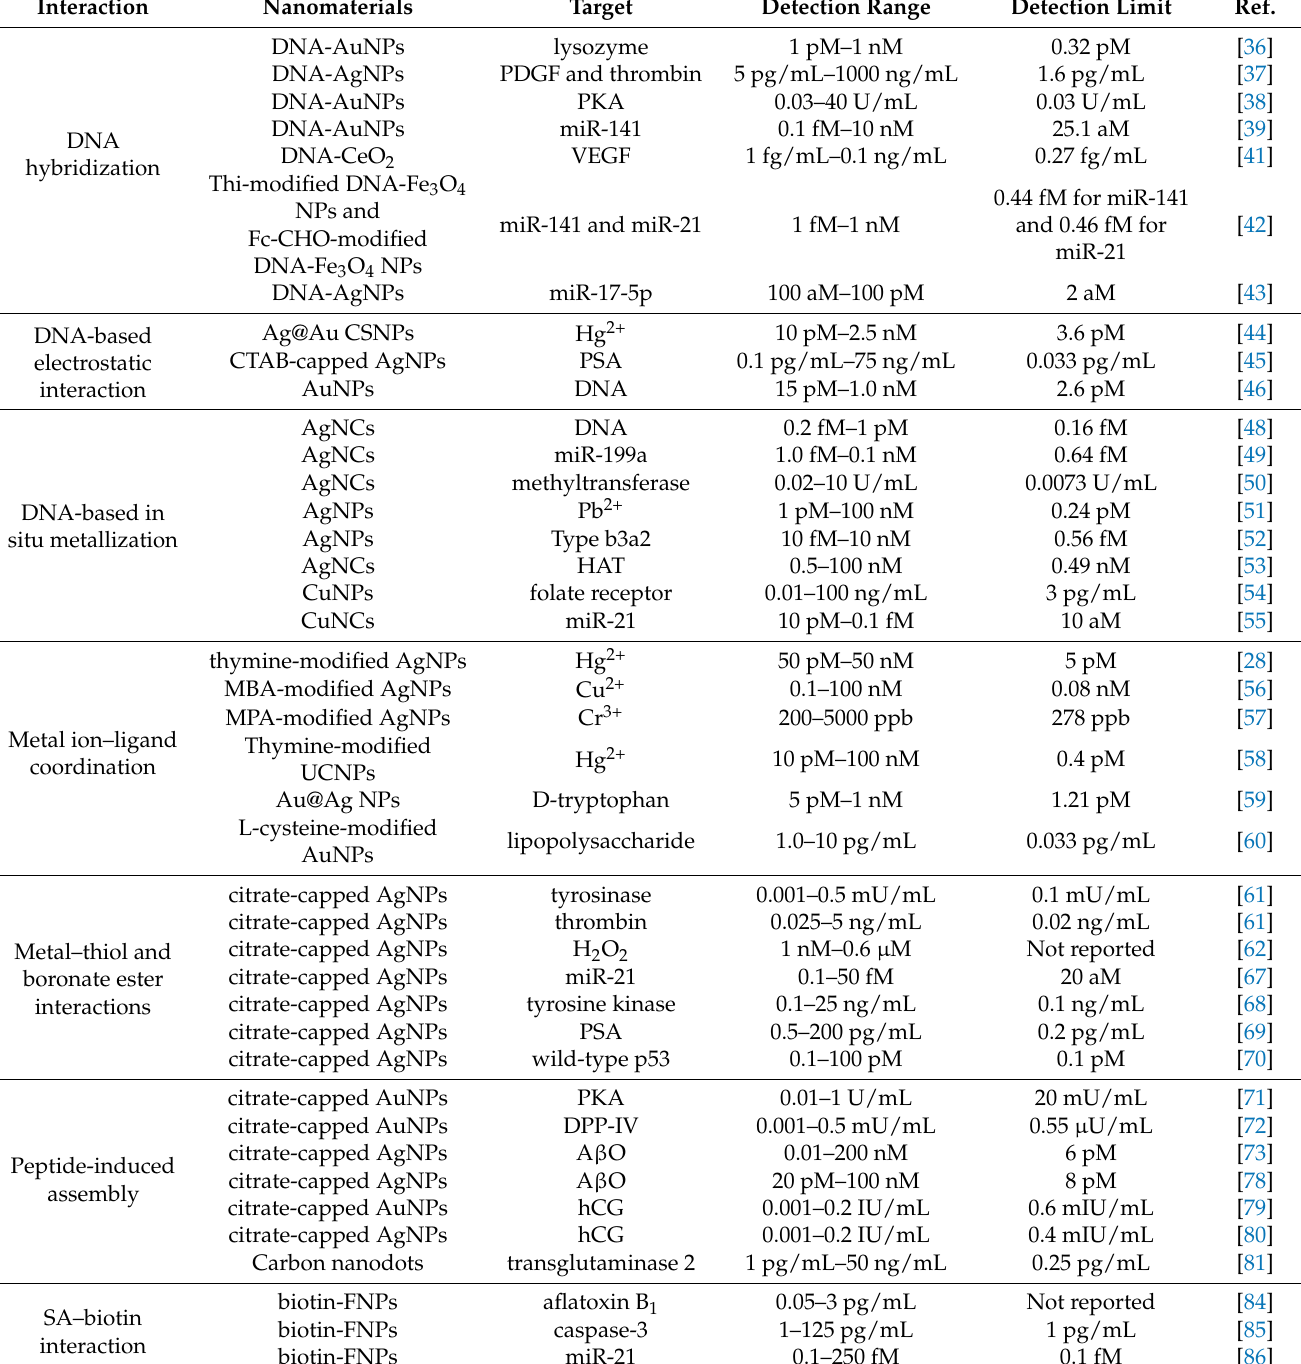
Table 1. Analytical performances of different electrochemical biosensors based on the in situ assembly of nanomaterials and molecules for the signal